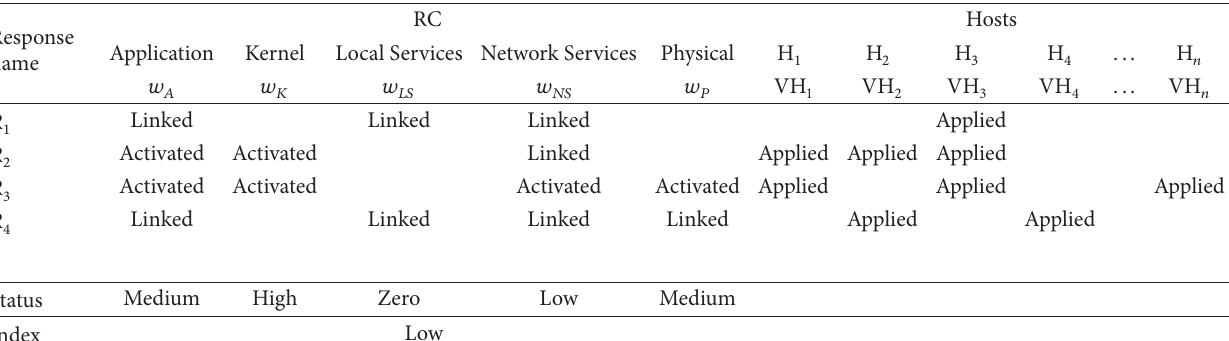
Table 1: Relationship between Responses and RC.